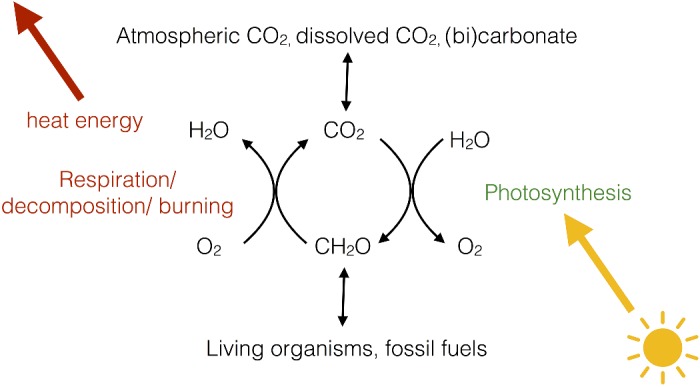
The global carbon cycleThe relationship between respiration, photosynthesis and global CO2 and O2 levels.